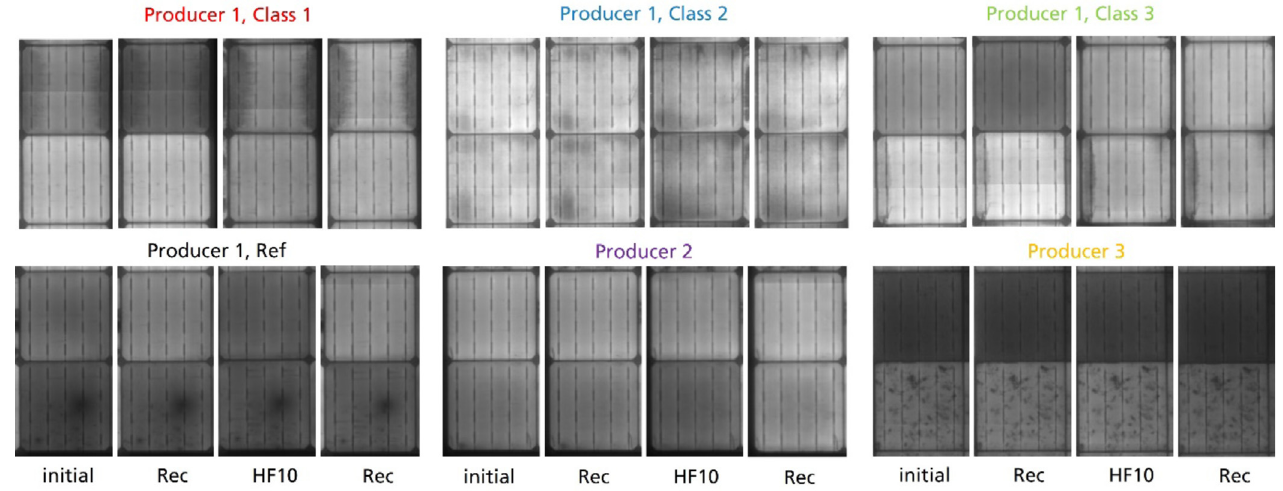
Fig. 8. Selected electroluminescence image sections from the sequential test, I =10 A, 1 s.